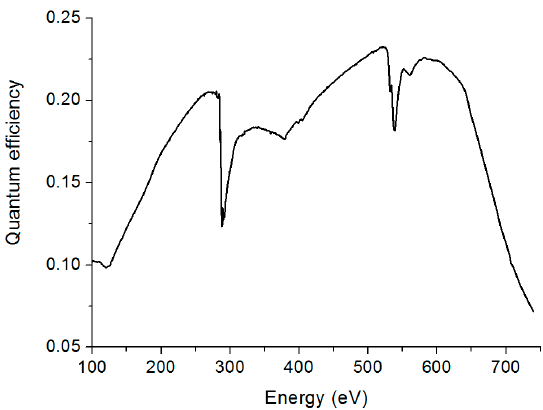
Figure 10. Total quantum efficiency of the spectrometer, using RZP 1 and RZP 2 (Figure 6a).